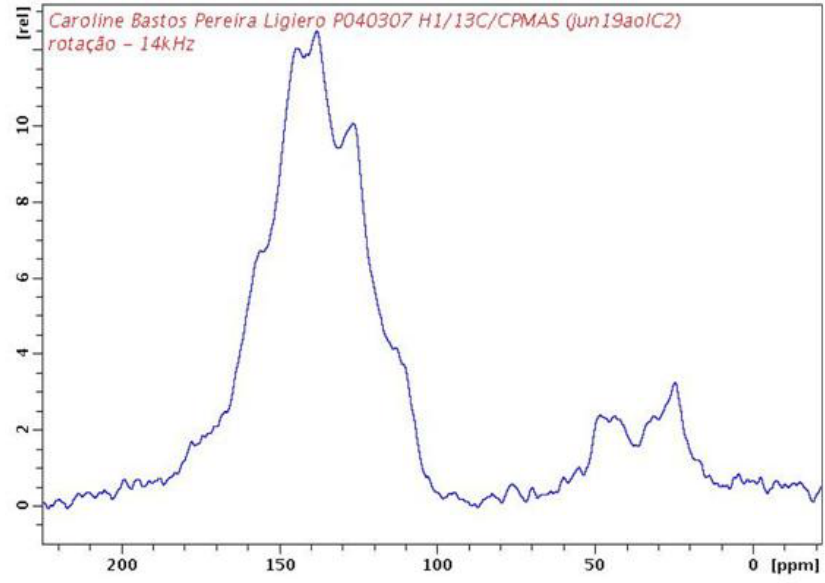
Figure 4. 13 C NMR spectra of PAPy ( DP = 18) at 100